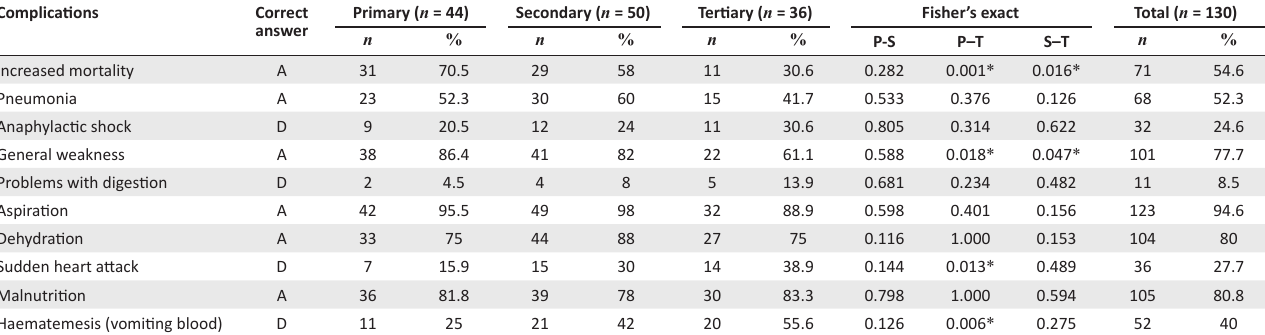
TABLE 3: Comparison of participants’ knowledge of complications of oropharyngeal dysphagia ( N = 130) . Complications